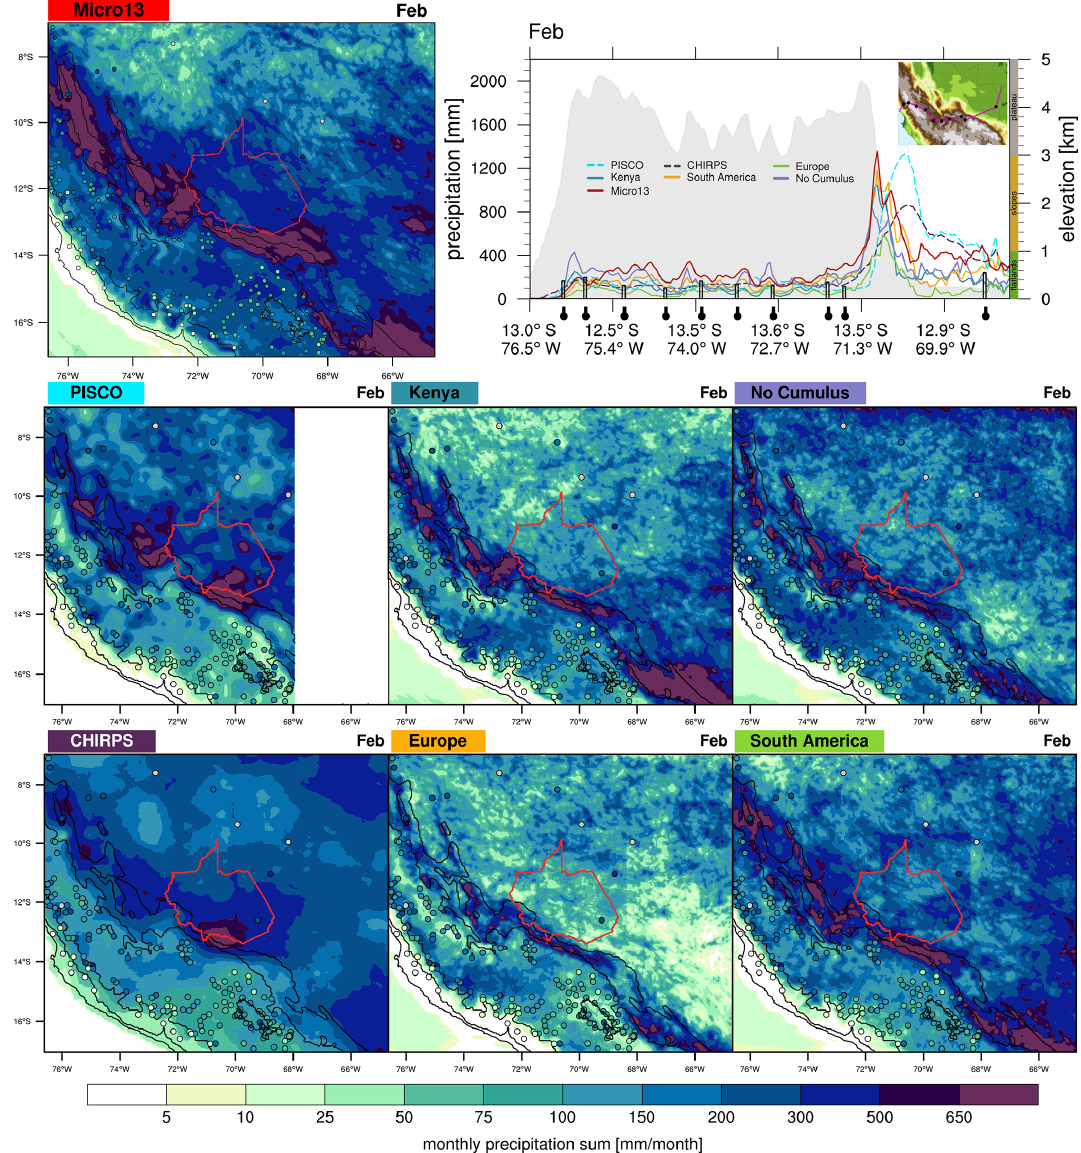
Figure 6. Monthly accumulated precipitation in millimetres per month for February 2008, a month in the rainy season, is shown for Micro13, Kenya, No Cumulus, Europe, and South America, and the gridded observational data sets PISCO and CHIRPS. The circles on the maps indicate the monthly accumulated precipitation recorded at the respective weather station. Grey dots indicate missing values at the respective station. Monthly accumulated precipitation along a transect through the Andes into Madre de Dios are also shown. The transect follows the purple line on the inset in the upper right corner of the plot. The dots on the inset and the symbols below the x axis mark the location of the weather stations. Precipitation measures from all the sensitivity simulations (full lines) and the reference data sets PISCO and CHIRPS (stippled lines) are depicted, while the observed precipitation amounts of each station along the transect are included as bars. The grey shading indicates the topography along this transect given in kilometres a.s.l. (right y axis). The separation into flatlands, slopes, and plateau is also given at the right side of the transect